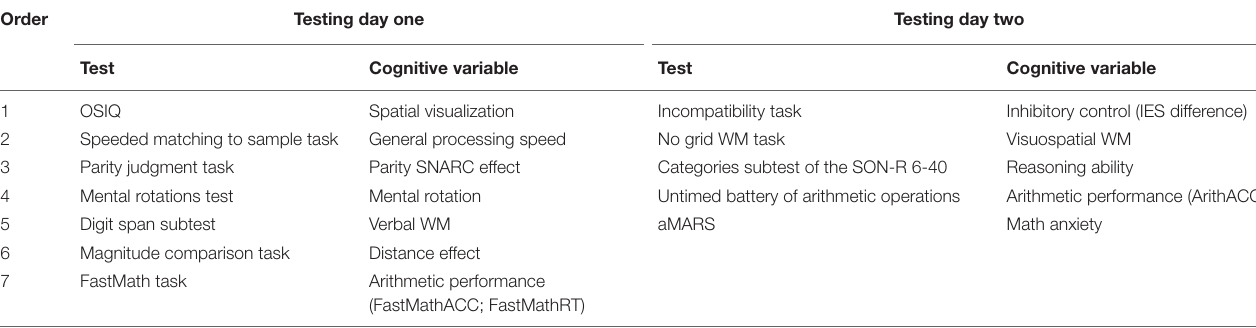
TABLE 1 | Order of the tests and the cognitive variables they assess on testing days one and